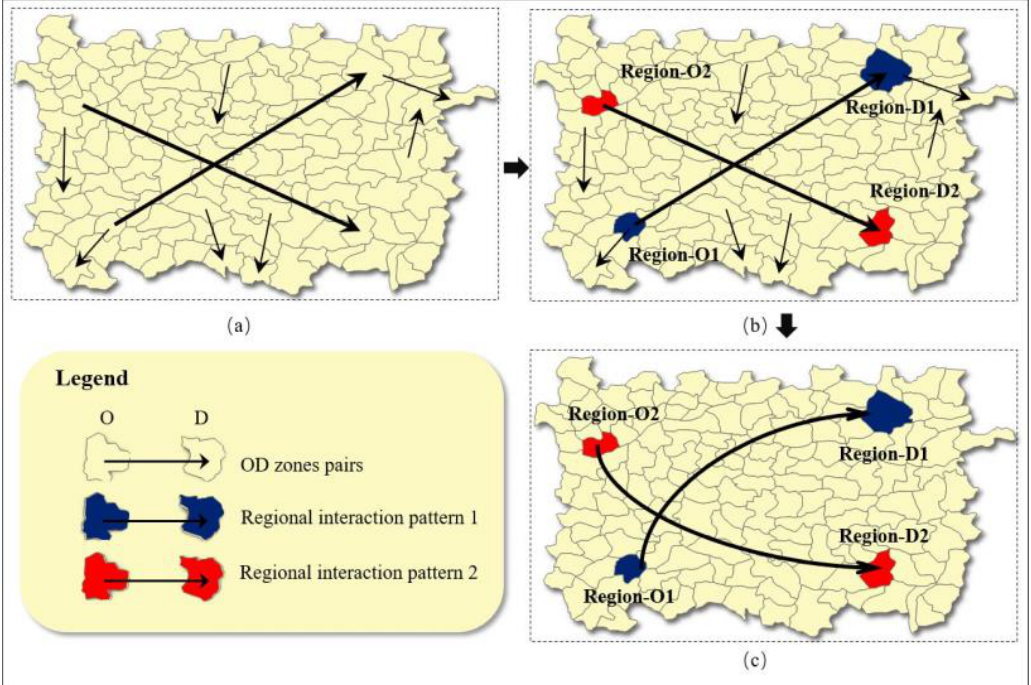
Figure 2. Example and analytical methods for regional flow data. ( a ) Area-to-area flow data; ( b ) area-to-area flow data with high interaction values; and ( c ) area-to-area flow patterns.